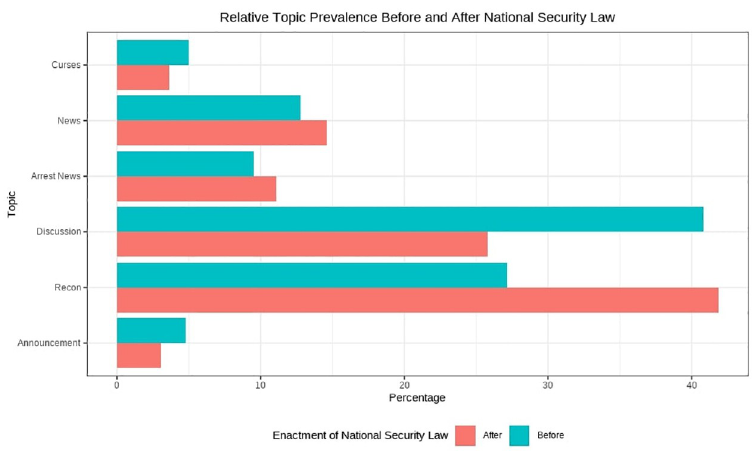
Fig 10. Topic prevalence before and after the introduction of the National Security